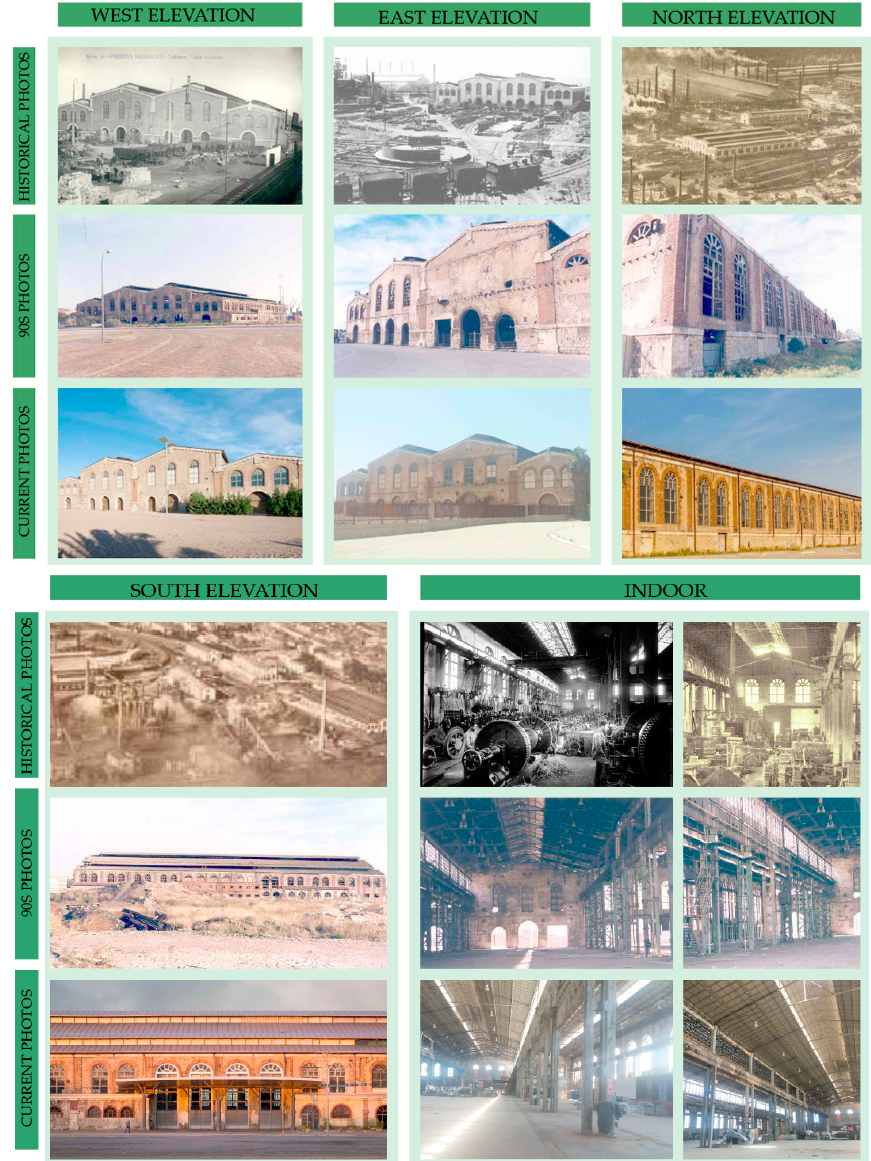
Figure 2. Analysis of the historical evolution of the “Nave de Talleres Generales” [52–56].